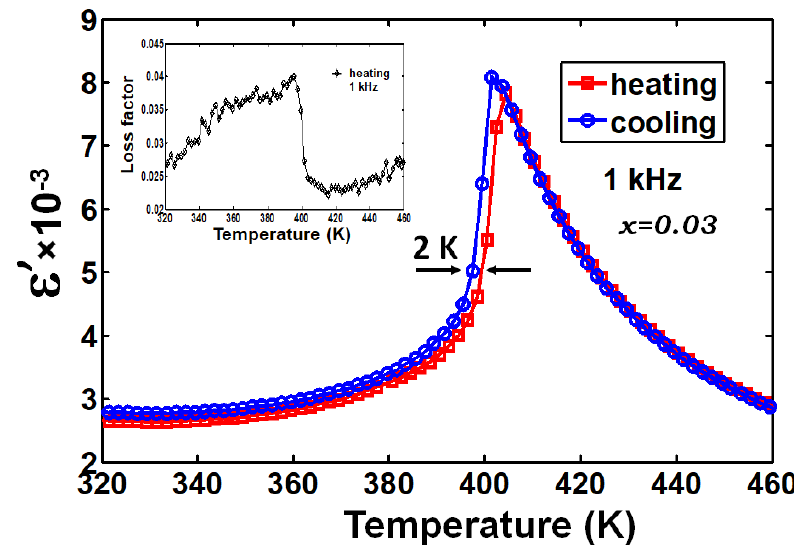
Figure 6. Thermal hysteresis loop of real permittivity for BTG3 compound, recorded at 1 kHz, showing a discard of ∆ T C = 2.00 K between heat and cool data. Inset the dielectric shows Loss factor.